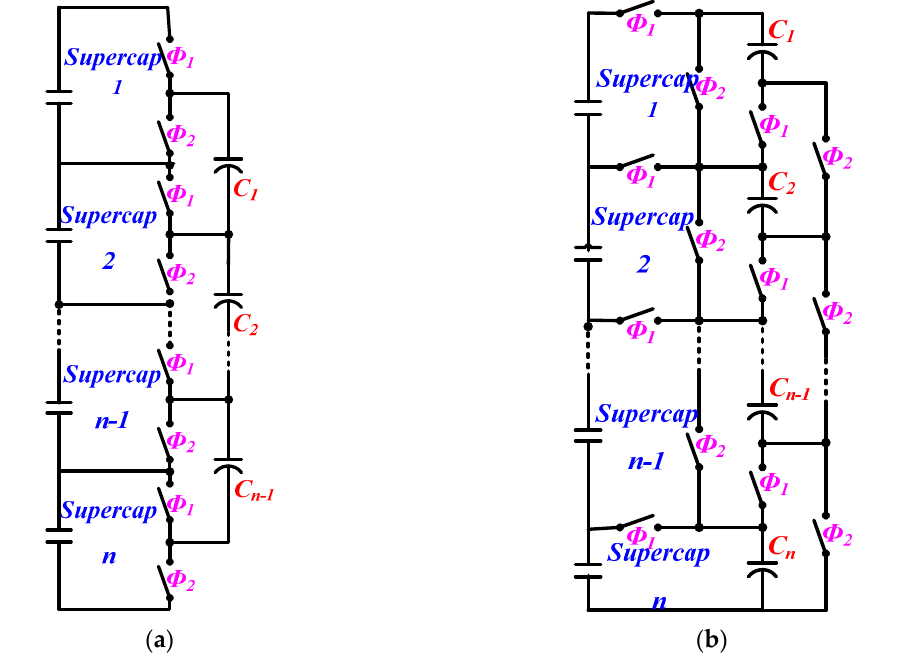
Figure 8. Supercapacitor module with switched capacitor balancing cell ( a ) traditional version ( b ) improved version.